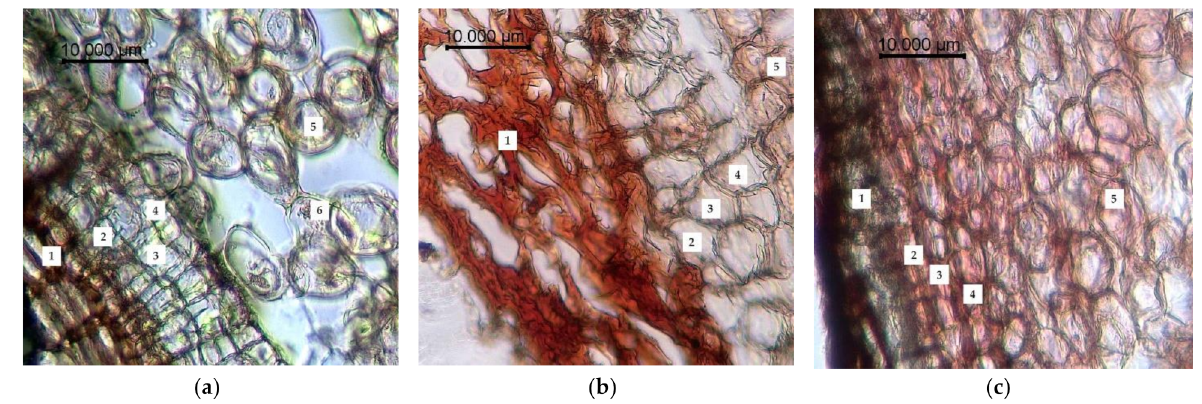
Figure 3. Changes in the anatomical structure of the root of R. semenowii under stress conditions: ( a ) control, ( b ) water deficit (cessation of watering, 72 h), ( c ) cold stress (cold treatment +3 ◦ C, 72 h). 1—periderm; 2—fellam; 3—phellogen;